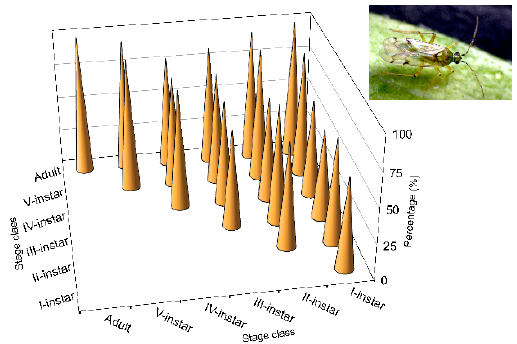
Figure 3. Survival (%) from Nesidiocoris tenuis cannibalism by life stage when caged with other conspecific of the same or lower stage class, over 72 h, under laboratory conditions (25 ± 1 °C and 60–80% RH) without prey.